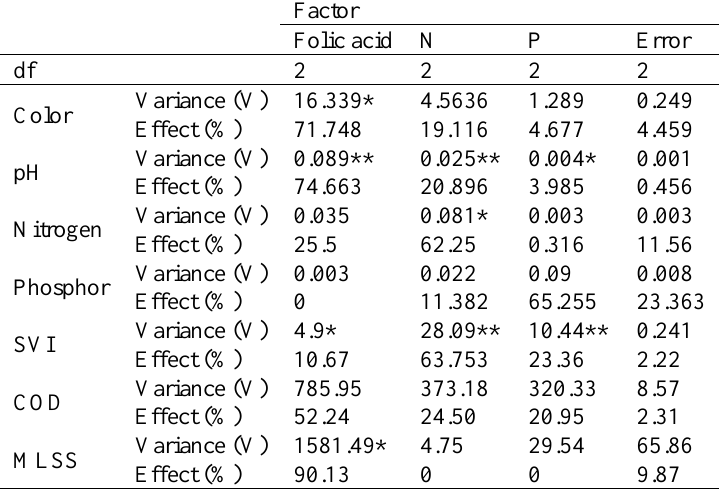
Table 5. Results of variance analysis for color, pH, nitrogen, phosphors, SVI, COD, and MLSS